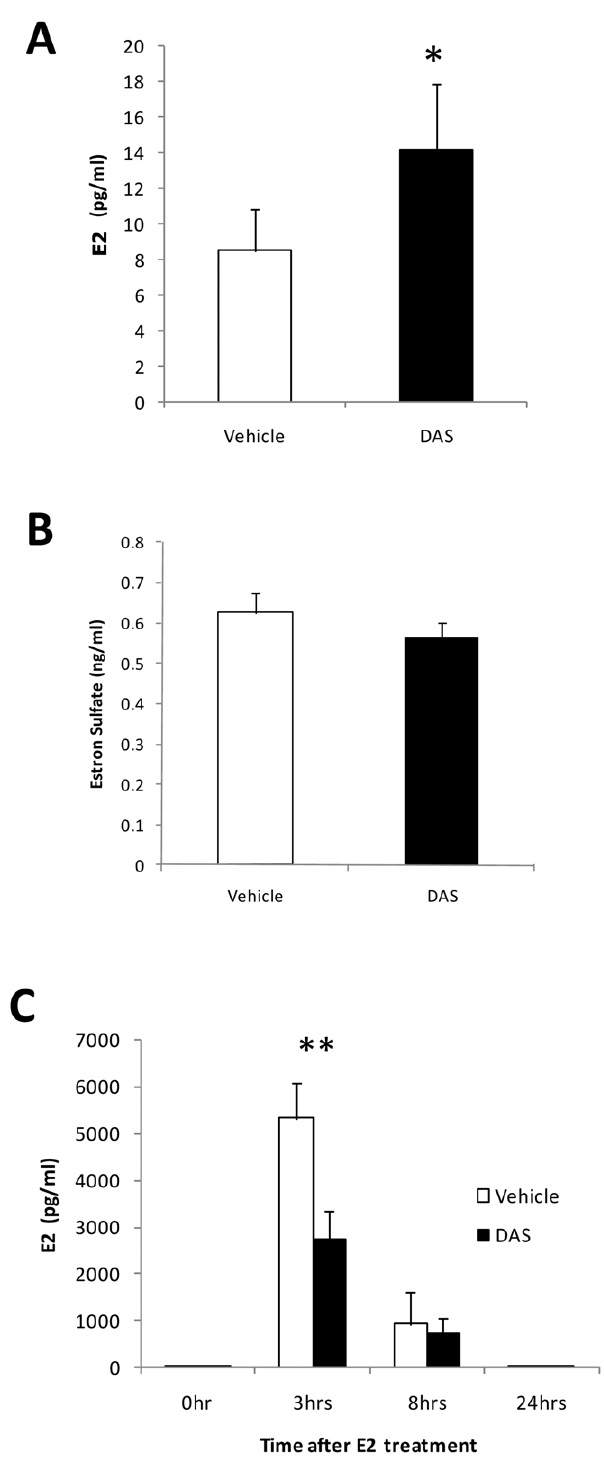
Figure 4. The effect of DAS treatment on serum estrogen. (A) E2 levels in sera from 4 week old mice treated with vehicle or DAS for 48 hrs are shown. * p , 0.05 for vehicle-injected group versus DAS- injected group. (B) Estrone sulfate levels in sera from 8 week old female mice treated with vehicle or DAS for 48 hrs are shown. (C) The clearance of exogenously administered E2 from mice sera was analyzed using DAS treated and vehicle treated ovariectomized mice. Ovariectomized mice were given DAS via gavage and E2 (0.5 mg/kg) was injected subcutaneously 42 hrs after the DAS administration. The E2 content in